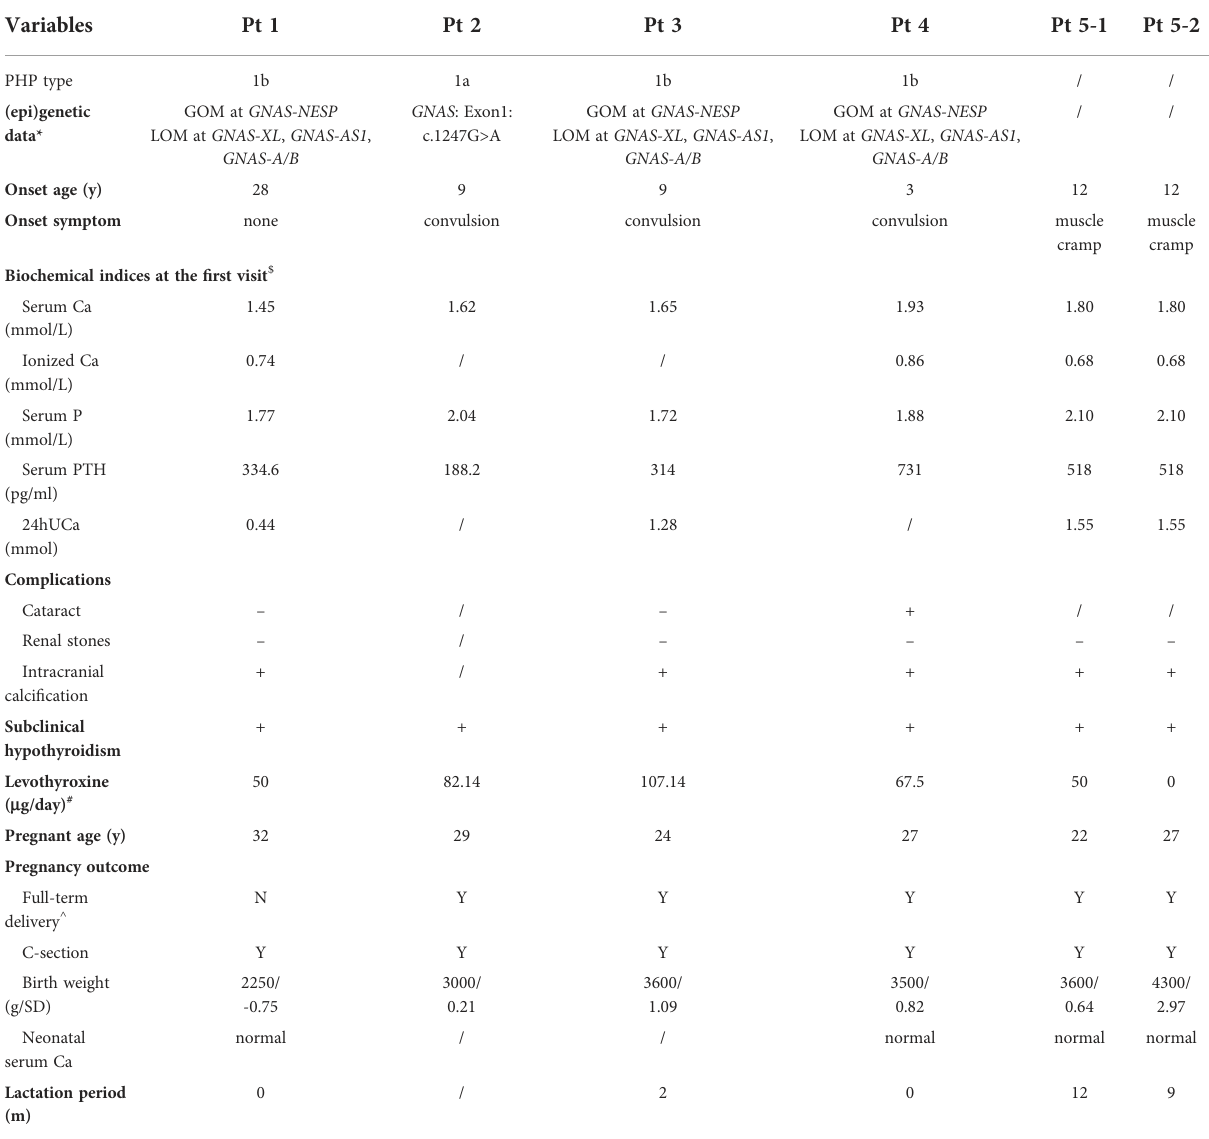
TABLE 1 General characteristics of the fi ve